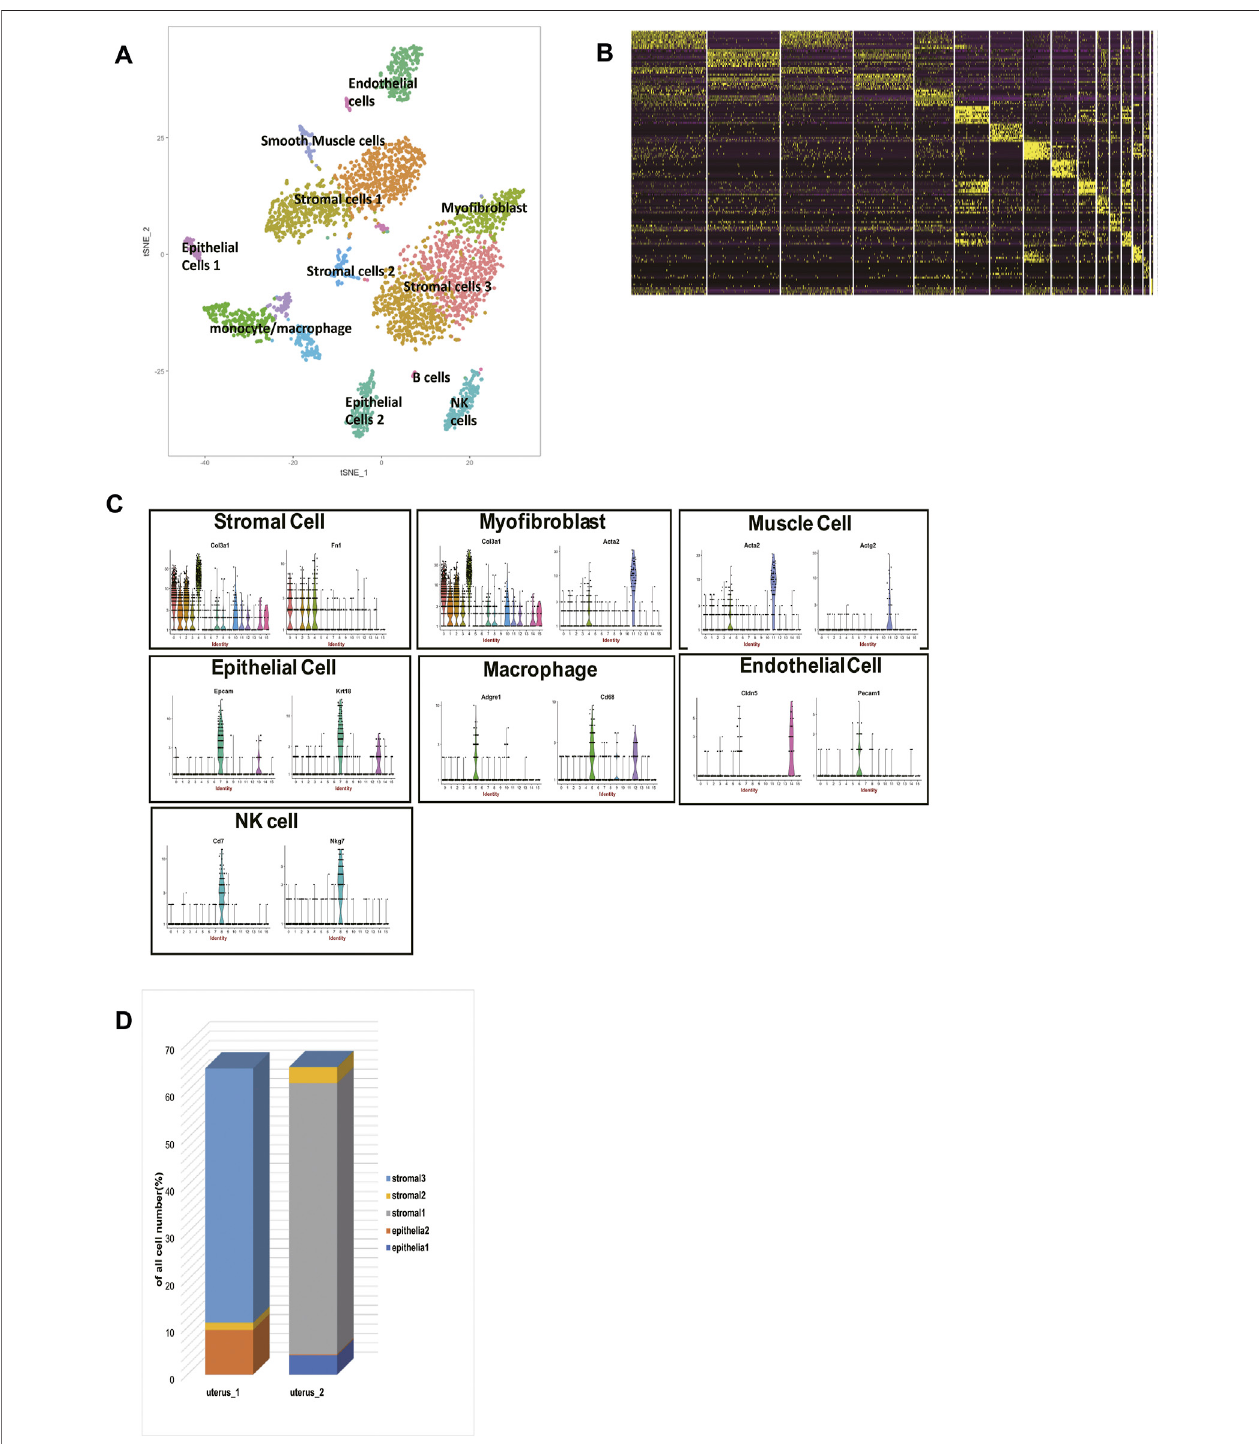
FIGURE1| single-cellRNAsequencinganalysisoftwomiceuteri. (A) t-distributedstochasticneighborembedding(t-SNE)diagramoftwomiceuteri. (B) Heatmap ofsinglecellsfromthetwouterirevealed16populations. (C) Violinplotsindicatingtheexpressionofmarkergenesofeachcellcluster. (D) Thecellcompositionofthetwo uteri was signi fi cantly different. T-SNE: t-distributed stochastic neighbor embedding.